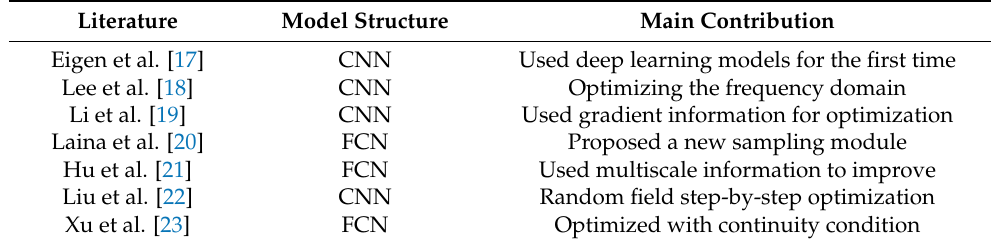
Table 1. Algorithm model